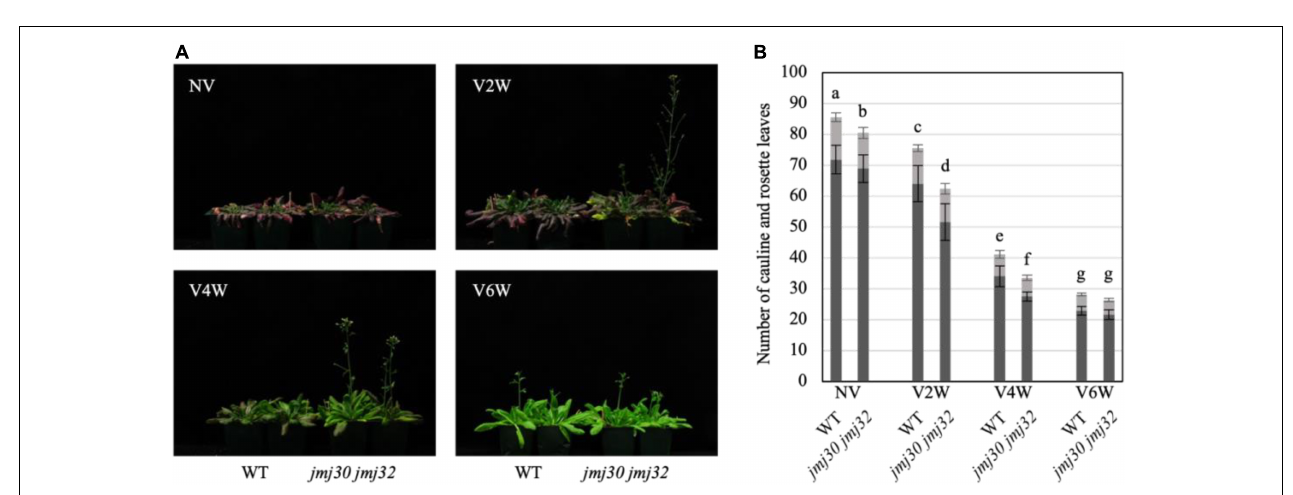
FIGURE 2 | jmj30 jmj32 exhibited the early flowering phenotype under the partial vernalized conditions. (A) Photographs of wild type and jmj30 jmj32 under different vernalized conditions (NV, non-vernalization; V2/4/6W, vernalization at 2/4/6 weeks). (B) Number of leaves, including cauline (gray) and rosette (black) leaves. Error bars represent SD. One-way ANOVA followed by the Tukey–Kramer test was performed ( p < 0.05). Different letters indicate significant differences, while the same letters indicate non-significant